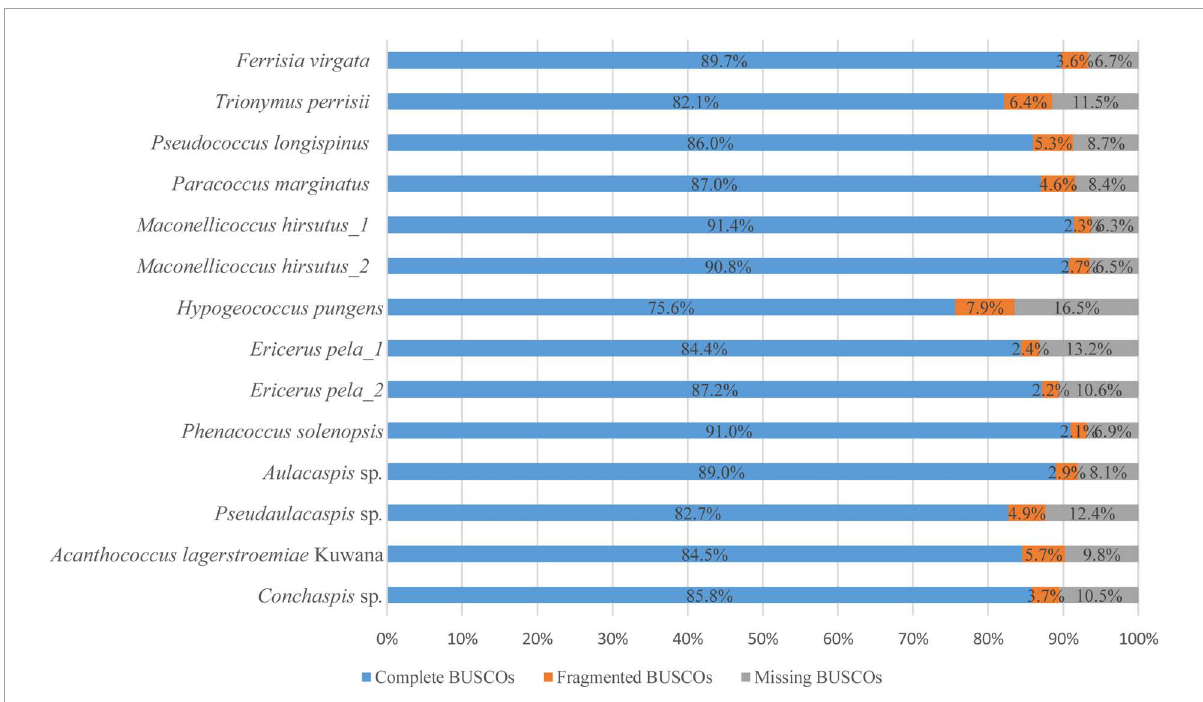
FIGURE1 BUSCO evaluation of ingroup genomes. In our study, BUSCO searched every ingroup genomes (4 from low coverage WGS, 10 from NCBI database) against hemiptera dataset, which contained 2,510 universal single-copy orthologs by August 5th 2020. Complete BUSCOs represent total matches of complete single-copy and complete duplicated BUSCOs. Fragmented BUSCOs mean the matches were partial and Missing BUSCOs mean no matches.